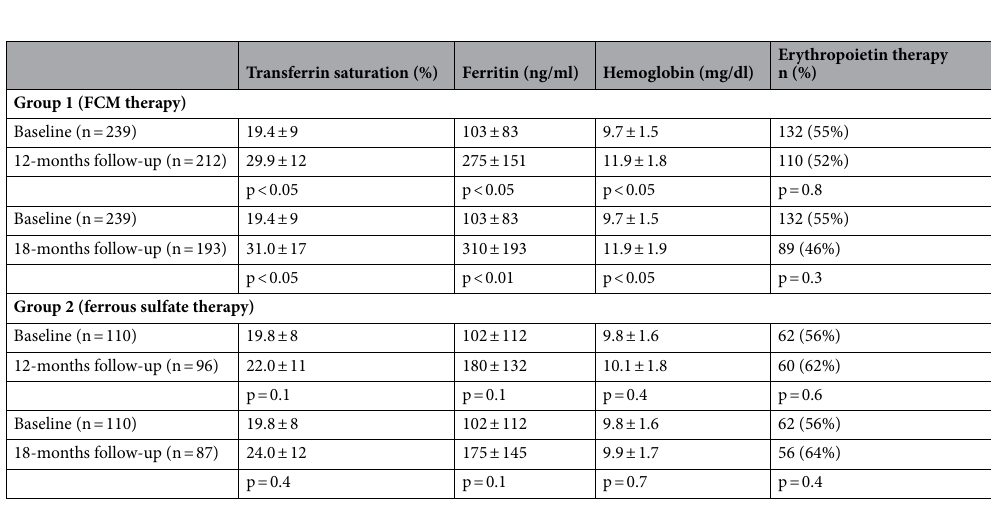
Table 2. Iron blood tests and hemoglobin at different time points in the two study